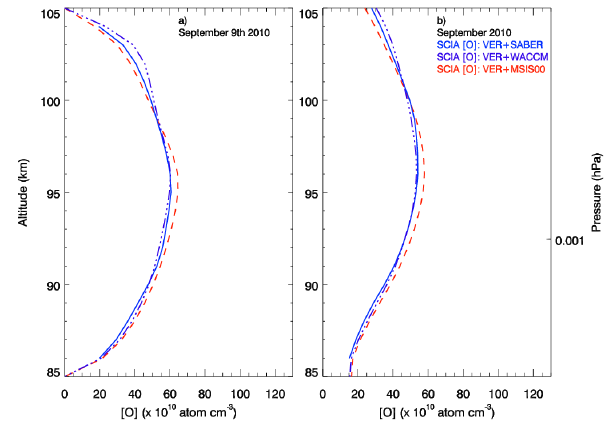
Figure 9. Sample daily (a) and monthly (b) averaged atomic oxy- gen concentration profiles (black solid [O quench profiles measured by SABER (blue dash dot [O SABER ]) and mod- eled with SD-WACCM4 (violet dash dot dot dot [O WACCM4 ]) and NRLMSISE-00 (red dashed [O MSIS00 ]) for the 20–25 ◦ N latitude range and at local times between 21:00 and 23:00.